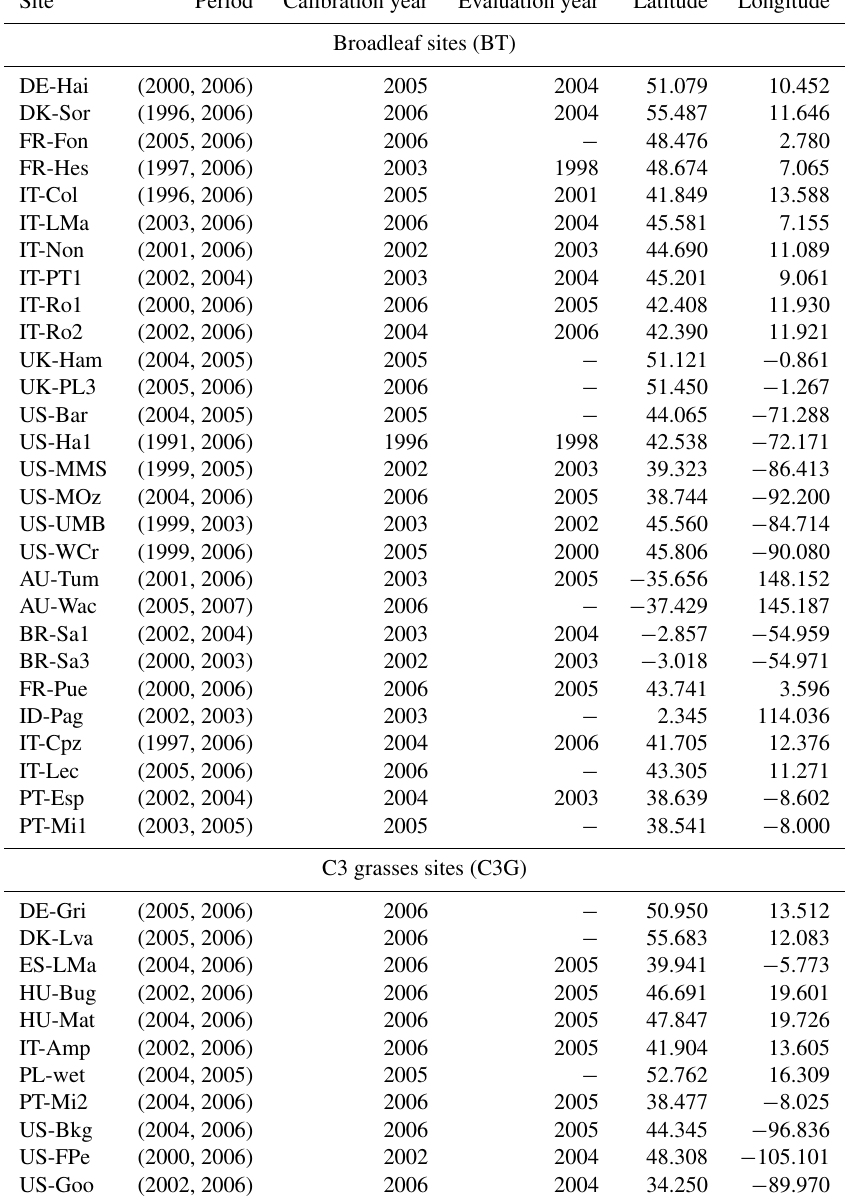
Table A1. FLUXNET sites used in this study, labelled by a country code (first two letters) and site name (last three letters). The period corresponds to the available years of data for each of the